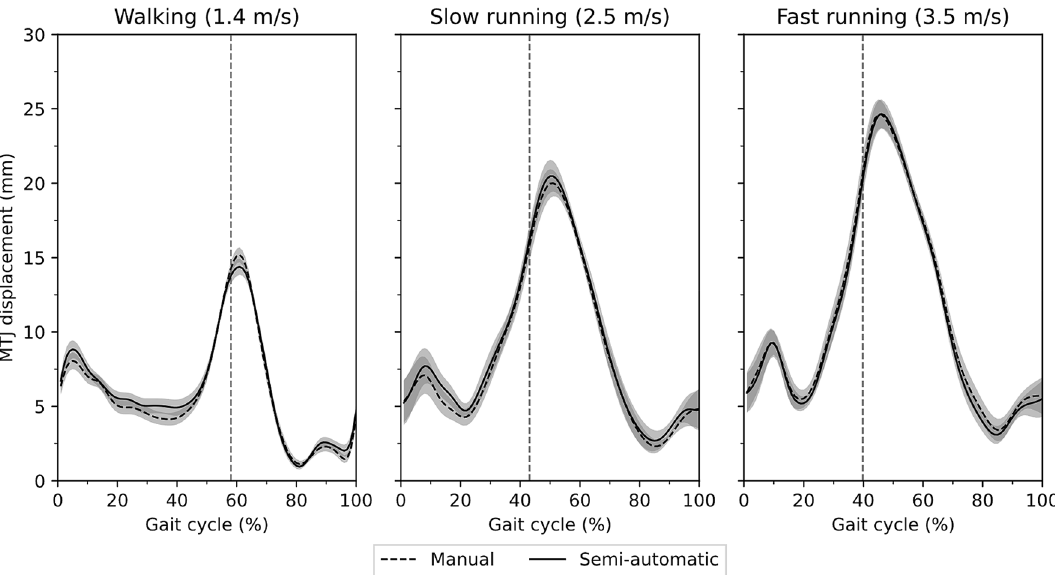
Figure 2. Displacement of the gastrocnemius medialis myotendinous junction using the self-developed semi- automatic algorithm compared to the manual tracking for walking, slow running, and fast running. The x-axis is normalized to the gait cycle. The gray highlighted areas are the standard errors. The gray dashed vertical line separates the contact and swing phase (average of seven participants with three gait cycle).